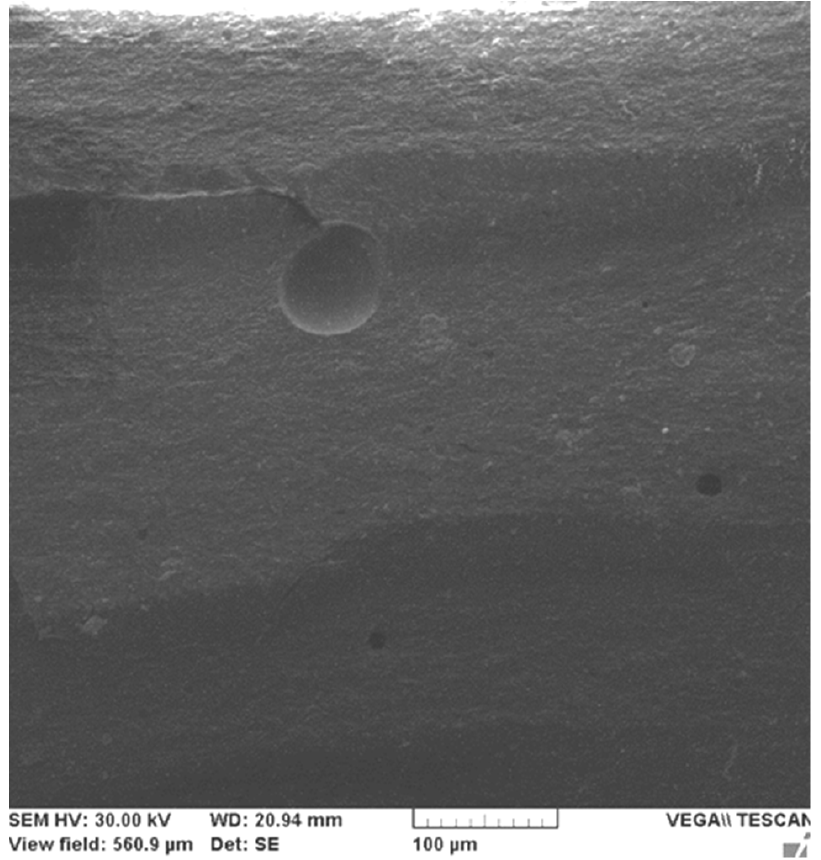
Figure 6. SEM microscopy of Filtek Z250-4 sample with microcrack blocked by a micrometer particle and areas with effective micro filler pull-outs.